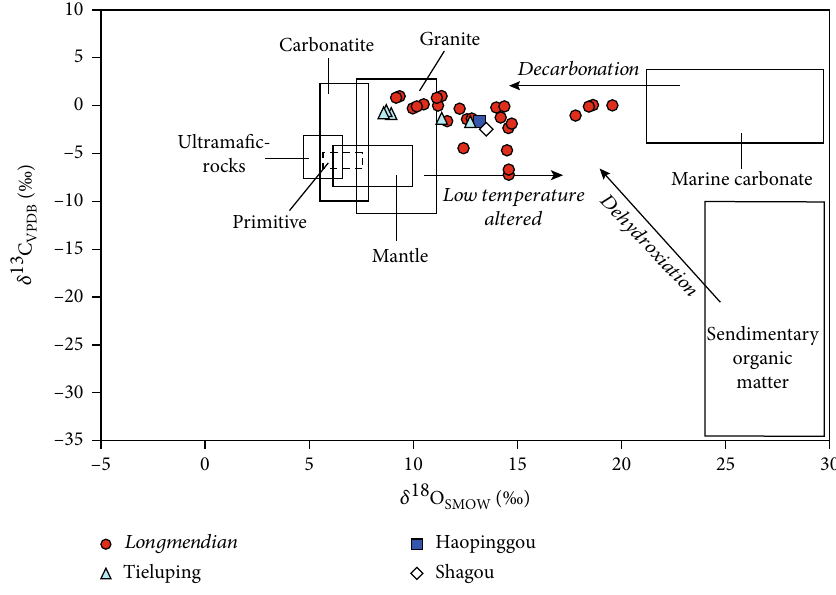
Figure 10: δ 13 C and δ 18 O values for ore fl uids of the Longmendian and other deposits (modi fi ed from [33, 34]).